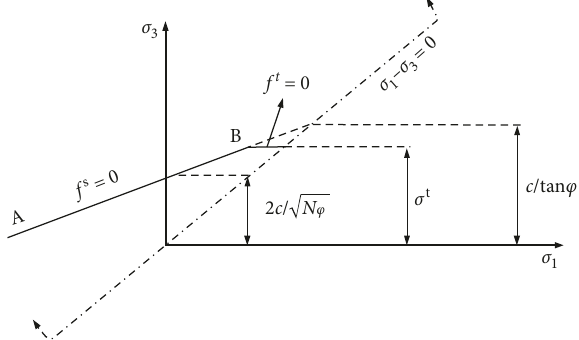
Figure 15: The Mohr–Coulomb yield criterion in principal stress space.